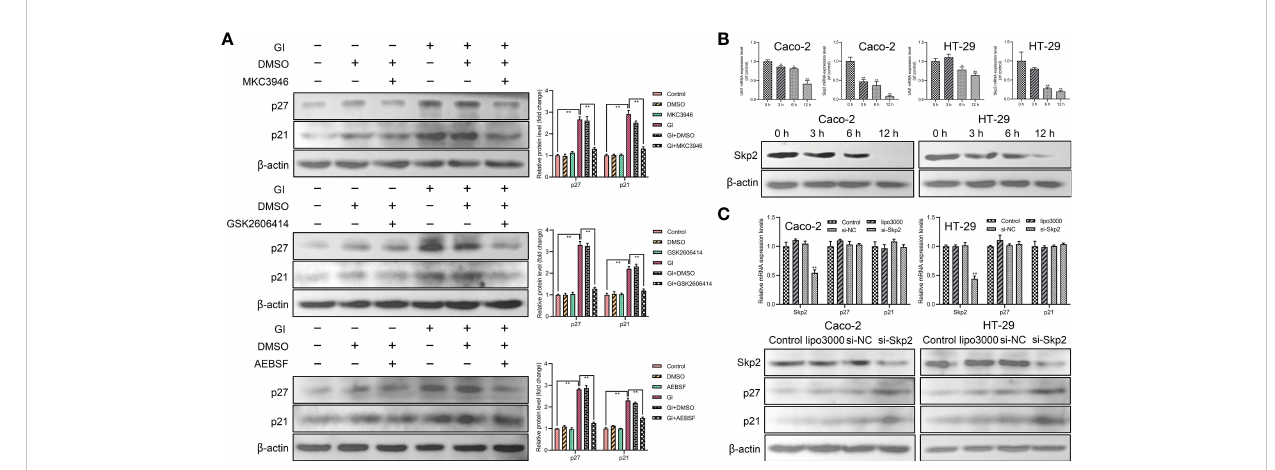
FIGURE 5 The expressions of p21 and p27 were enhanced by Giardia exposure via activating UPR pathways. (A) Western blot analysis (n = 3) was used to measure the protein levels of p21 and p27 in Caco-2 cells treated with or without inhibitors accompanied by Giardia exposure for 6 h; IRE1 inhibitor (MKC3946), PERK inhibitor (GSK2606414) and ATF6 inhibitor (AEBSF). The results of western blot analyses were normalized against the level of b - actin. Gl, Giardia . (B) The qPCR analysis was used to detect the mRNA levels of Ufd1 and Skp2 with Giardia exposure in Caco-2 and HT-29 cells. The protein expression of Skp2 with Giardia exposure in Caco-2 and HT-29 cells was detected by western blotting. (C) The qPCR and western blot analysis were used to measure mRNA and protein expression levels of Skp2, p21 and p27 in Caco-2 and HT-29 cells transfected with si-Skp2/si-NC for 48 h. All experiments were repeated at least three times. Data were presented as mean ± SD. * p < 0.05, ** p < 0.01 versus relative control group. (B, C) The results of qPCR analyses (n = 3) were normalized against the level of GAPDH. (A – C) Representative pictures are shown.